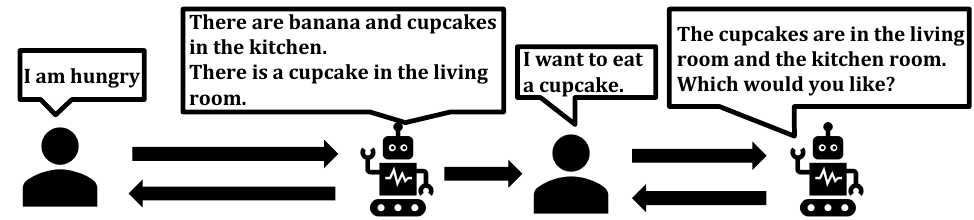
Figure 1. Example of interaction with the